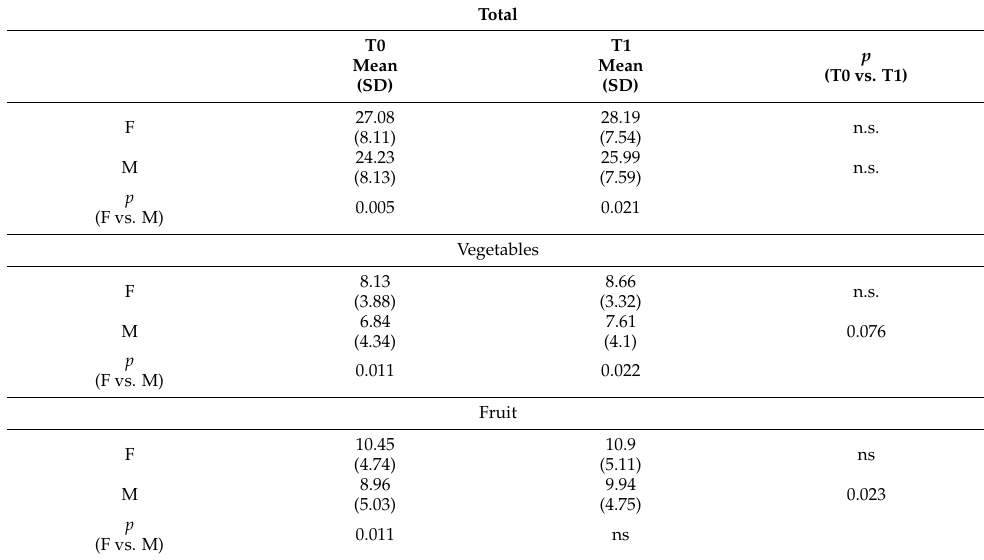
Table 6. Total and individual scores for vegetables and fruit disaggregated by